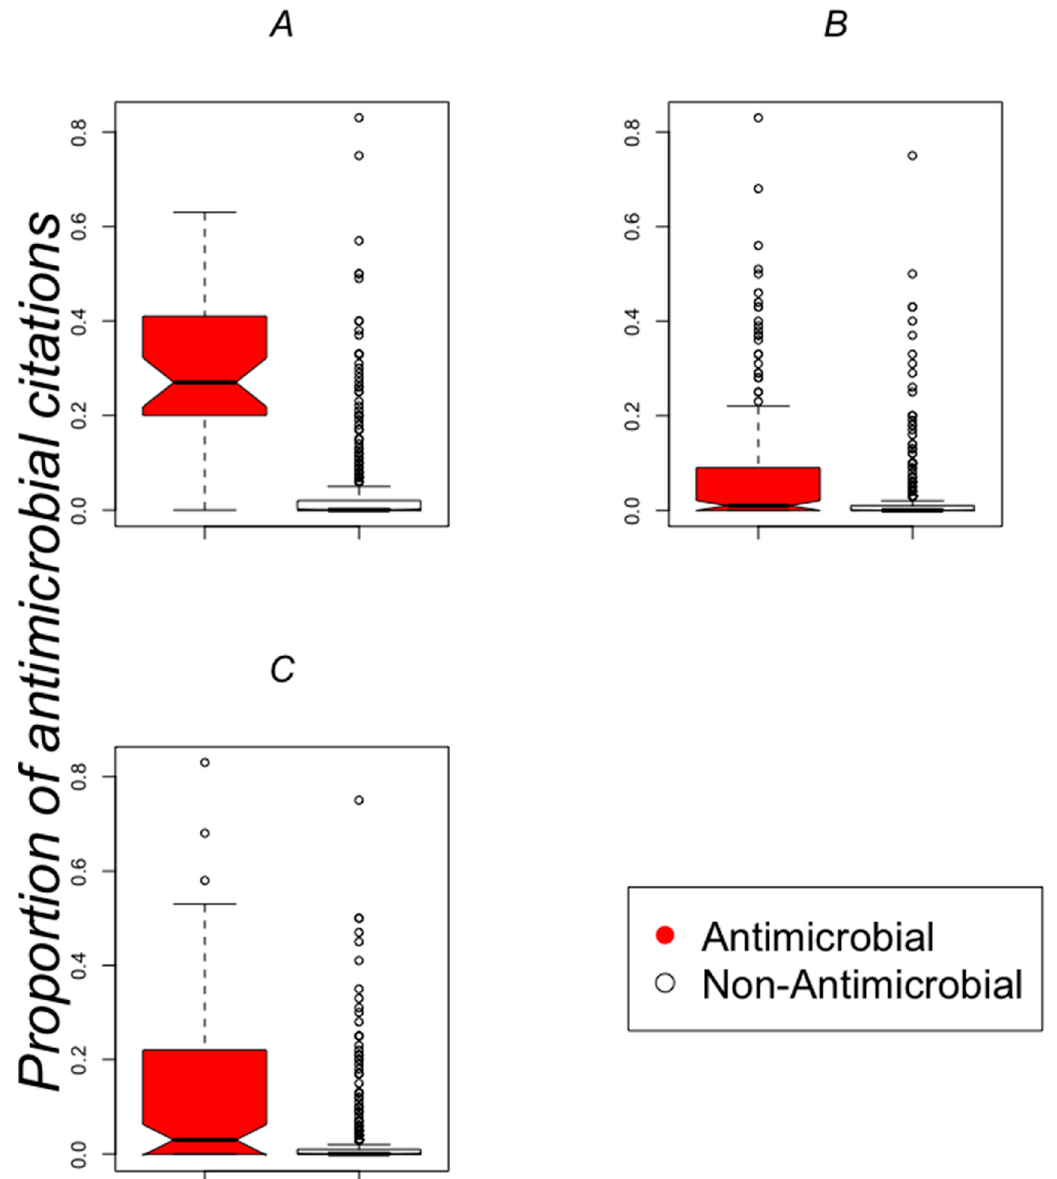
Figure 2. PubMed citations with ontological terms associated with antimicrobial activity. ( A ) Anti-infective, ( B ) anti-gut1 and ( C ) anti-gut4 data sets. The images present the distribution of the proportion of publications that included an ontological term related to antimicrobial activity with respect to the total number of publications reported for every compound tested by Maier and collaborators; to see the actual ontological terms, please refer to Table 1. The data are presented in box plots, where the first and third quartile are represented below and above the black line that corresponds with the mean value of the distribution. Every box plot presents the data for each of the 572 compounds that presented at least one publication with ontological terms associated with antimicrobial activity, out of the 1181 compounds tested by Maier and collaborators. Red boxes represent antimicrobials, white otherwise.